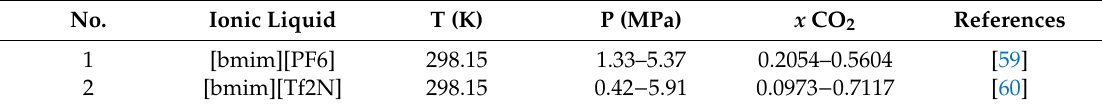
Table 4. Ranges of temperature, pressure, and CO 2 solubility in [bmim][Tf2N] and [bmim][PF6] ILs. No.